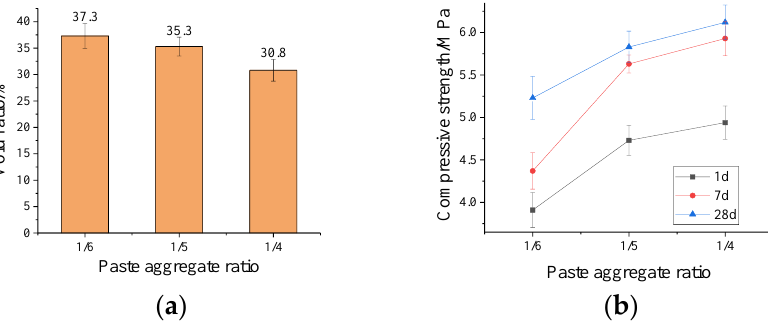
Figure 7. Effect of paste aggregate ratio on ( a ) void ratio and ( b ) compressive strength of porous ecological concrete.